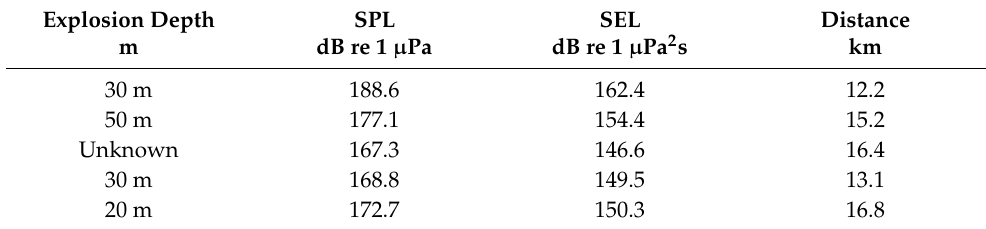
Table 5. Selection of reported measurement results with data from